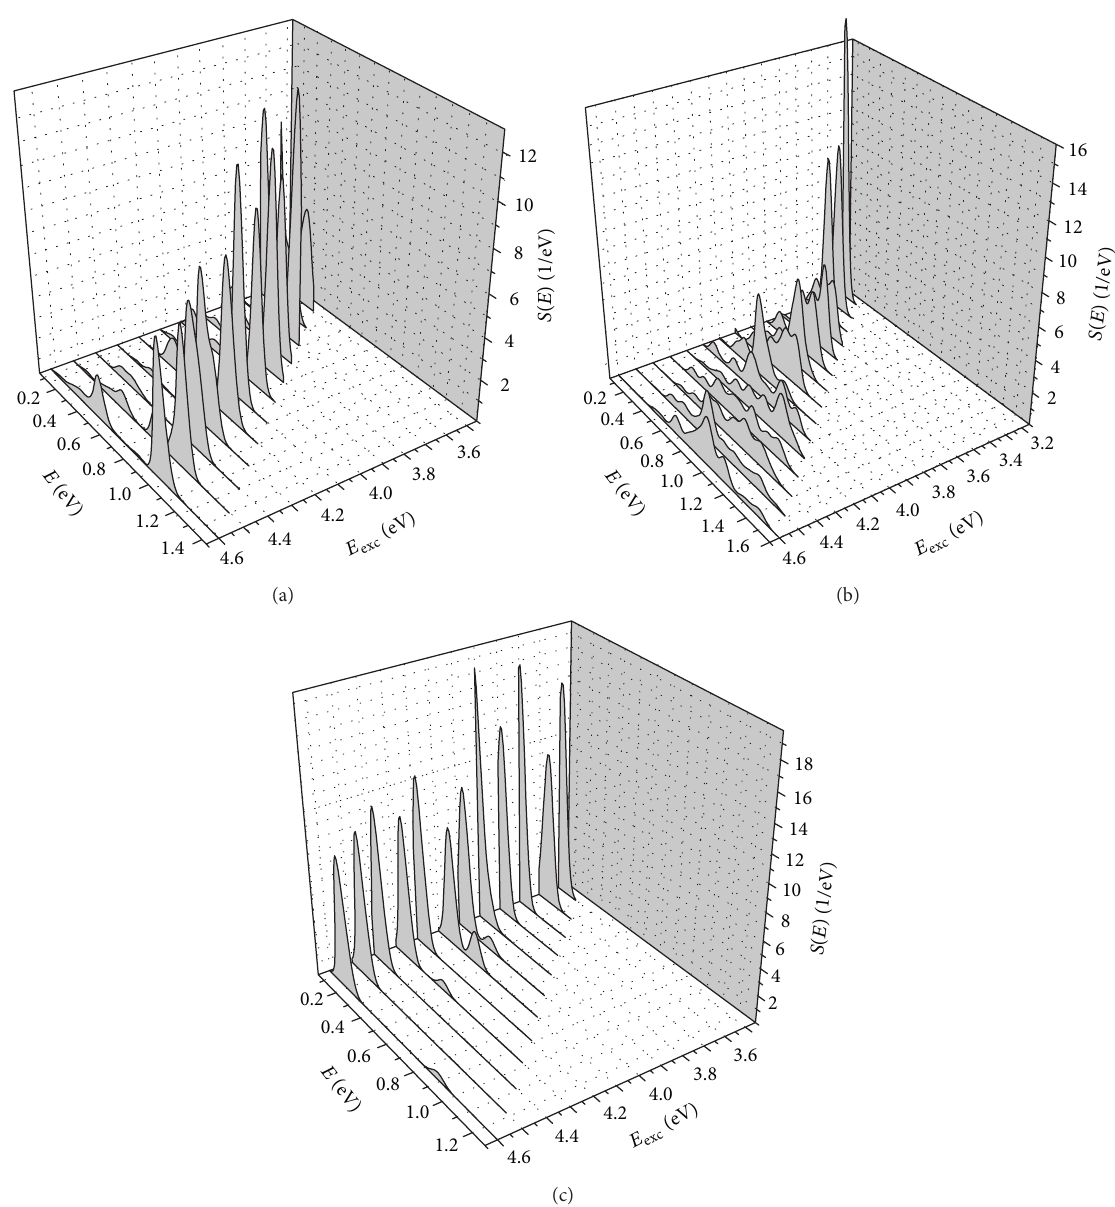
Figure 8: Instantaneous distribution function for anatase (a), rutile (b), and zinc oxide (c) depending on the excess energy of hole 𝐸 , as from 3.4 eV to 4.6 calculated for the photon energy 𝐸 exc